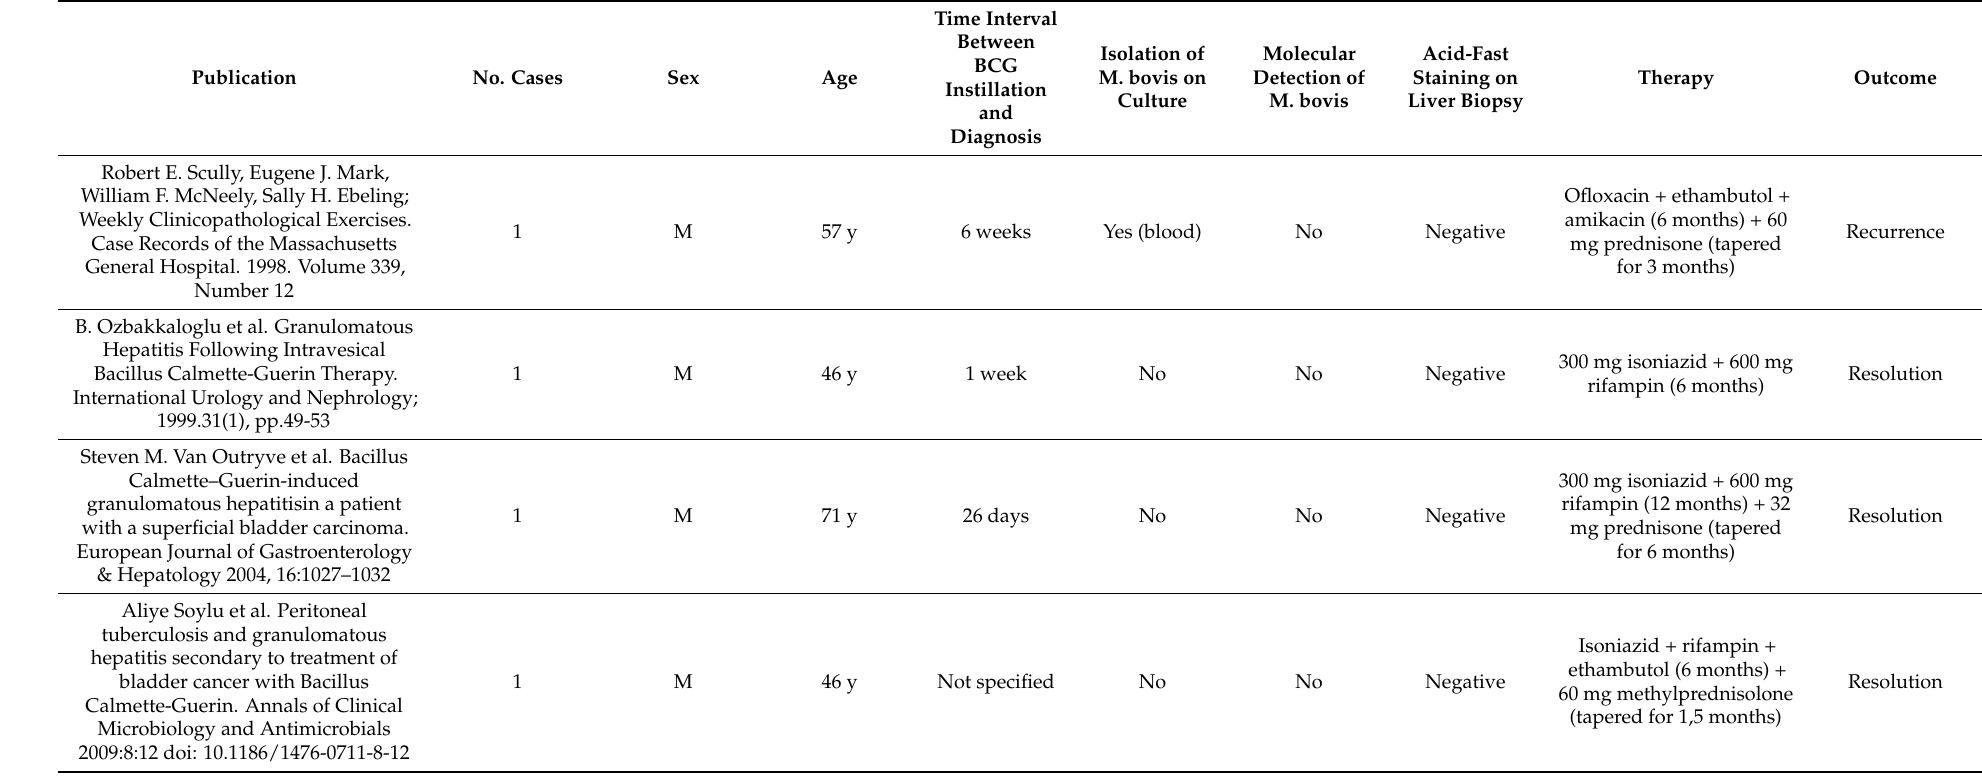
Table 2. Summary of some cases of granulomatous hepatitis following intra-vesical BCG therapy published in the